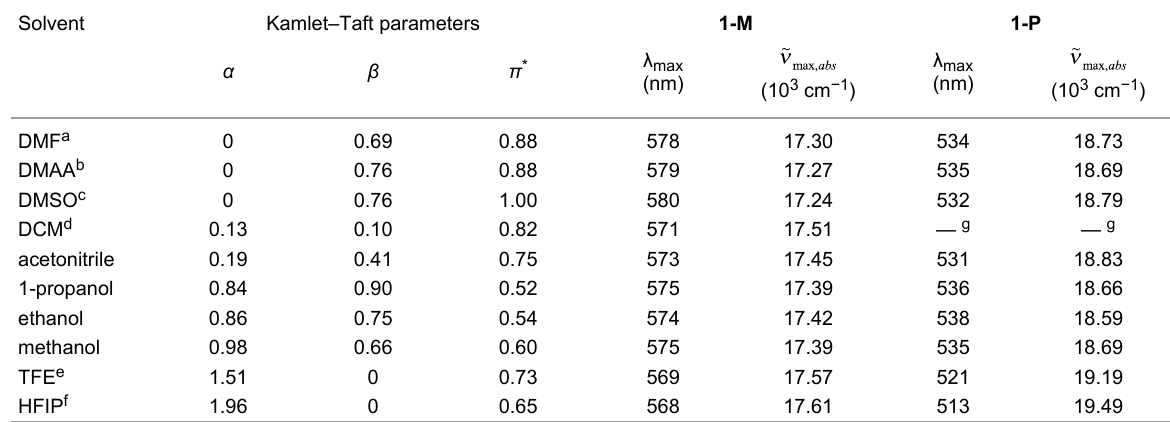
Table 2: UV–vis absorption maxima,